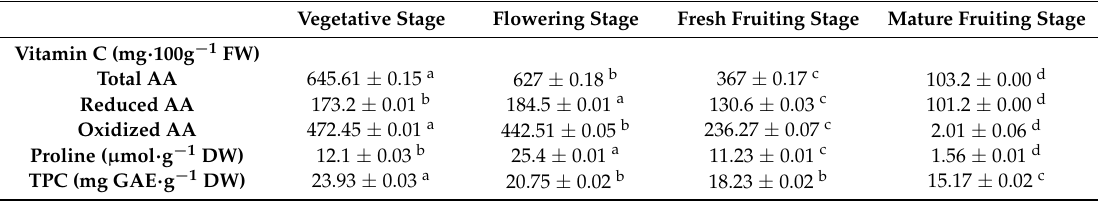
Table 2. Contents of ascorbic acid, proline, and total phenolic compounds (TPC) of Retama raetam (Forssk.) Webb shoots at different grown